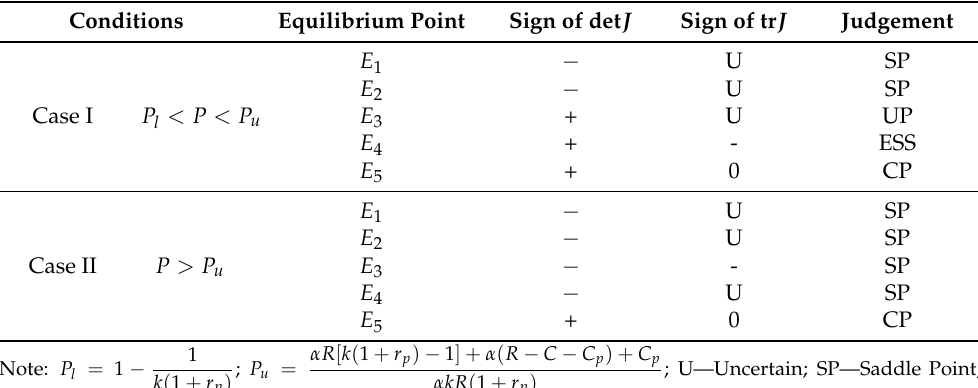
Table 2. Stability judgment and analysis of equilibrium point of accounts receivable factoring business before applying blockchain technology. Conditions Equilibrium Point Sign of det J Sign of tr J Judgement